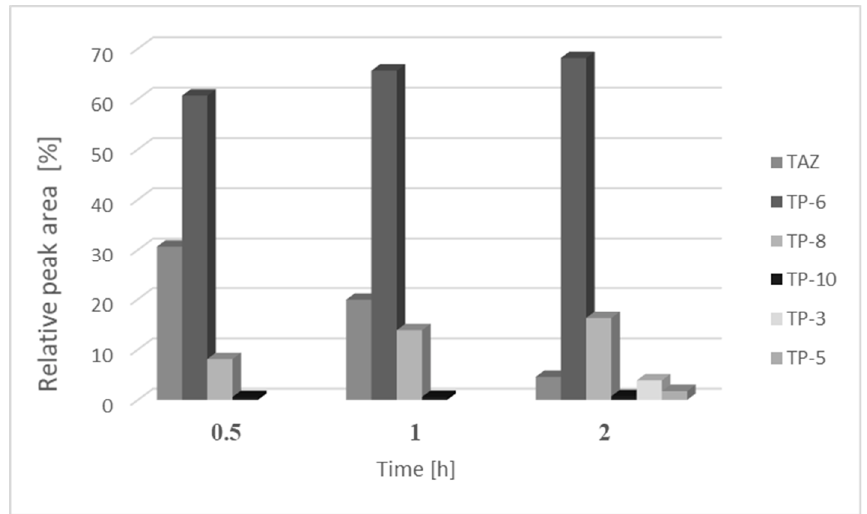
Figure 3. Average relative peak areas of tazarotene and its main photocatalytic degradation products identified in the tested solutions after 0.5, 1, or 2 h of UV irradiation in the presence of TiO 2 /ZnO. TAZ—tazarotene; TP-3, TP-5, TP-6, TP-8, and TP-10—photocatalytic degradation products of